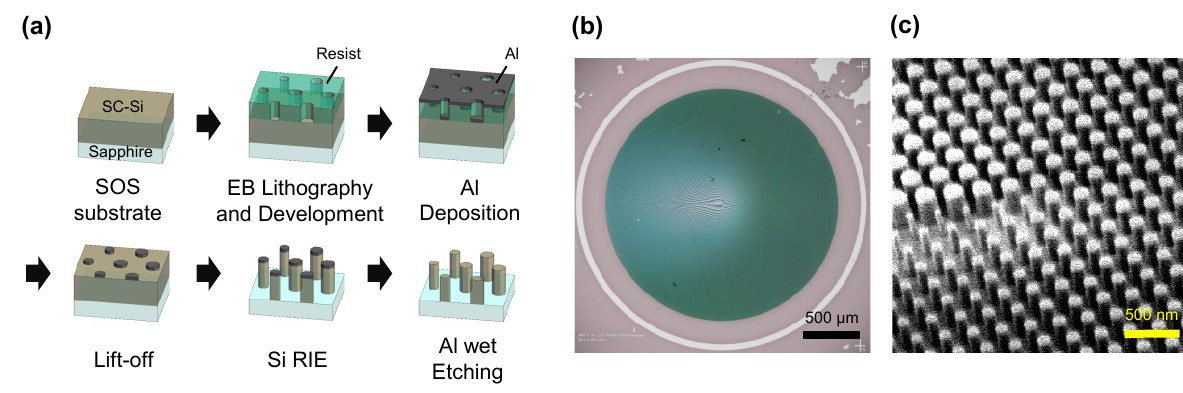
Figure 2: Fabrication of the moiré metalens. (a) Fabrication process flow. (b) Microscope image of the fabricated metasurface with a diameter of 2 mm on the sapphire substrate. (c) SEM image of the center of the fabricated metasurface.